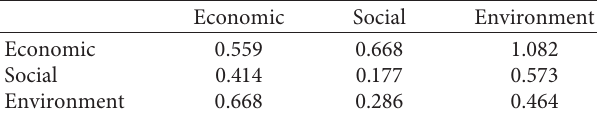
Table 23: Comparison matrix of linguistic variable of sustainability dimensions in deterministic condition.